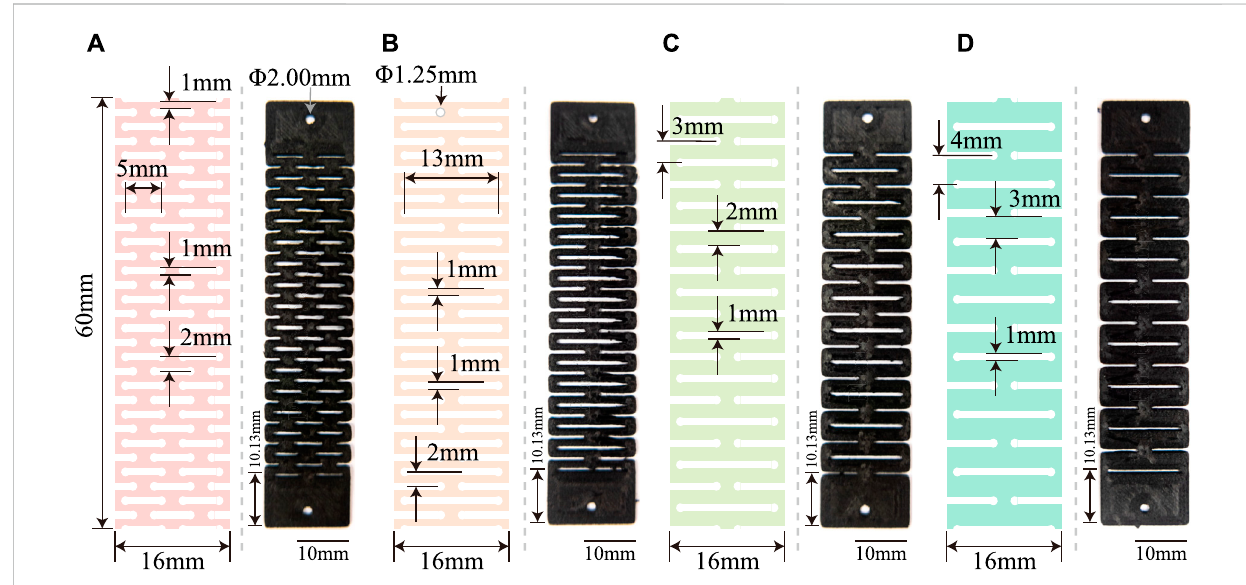
FIGURE 4 Kirigami-inspired patterns and photos of planar springs. (A) Double-Column-Flat-2mm pattern; (B) Single-Column-Flat-2mm pattern; (C) Single- Column-Flat-3mm pattern; (D) Single-Column-Flat-4mm pattern. Dimensions of the kirigami patterns are listed in the fi